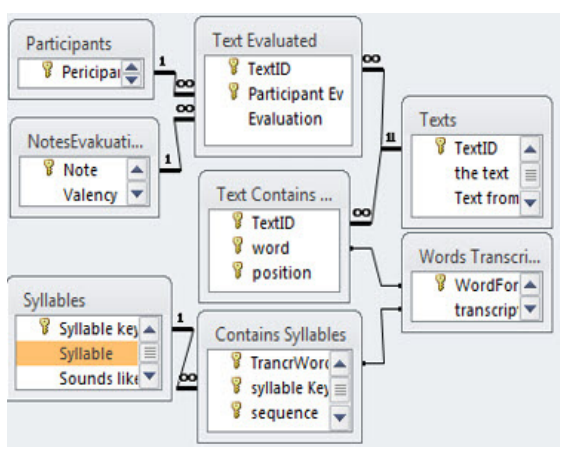
Figure 3. Data Base - organization of